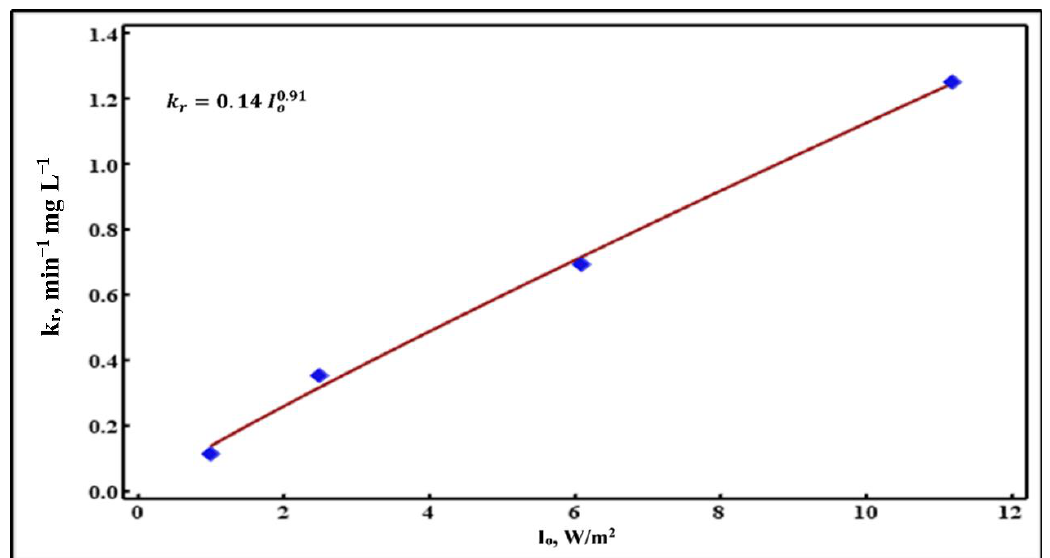
Figure 9. Non-linear regression of k r values vs. various catalyst loadings.